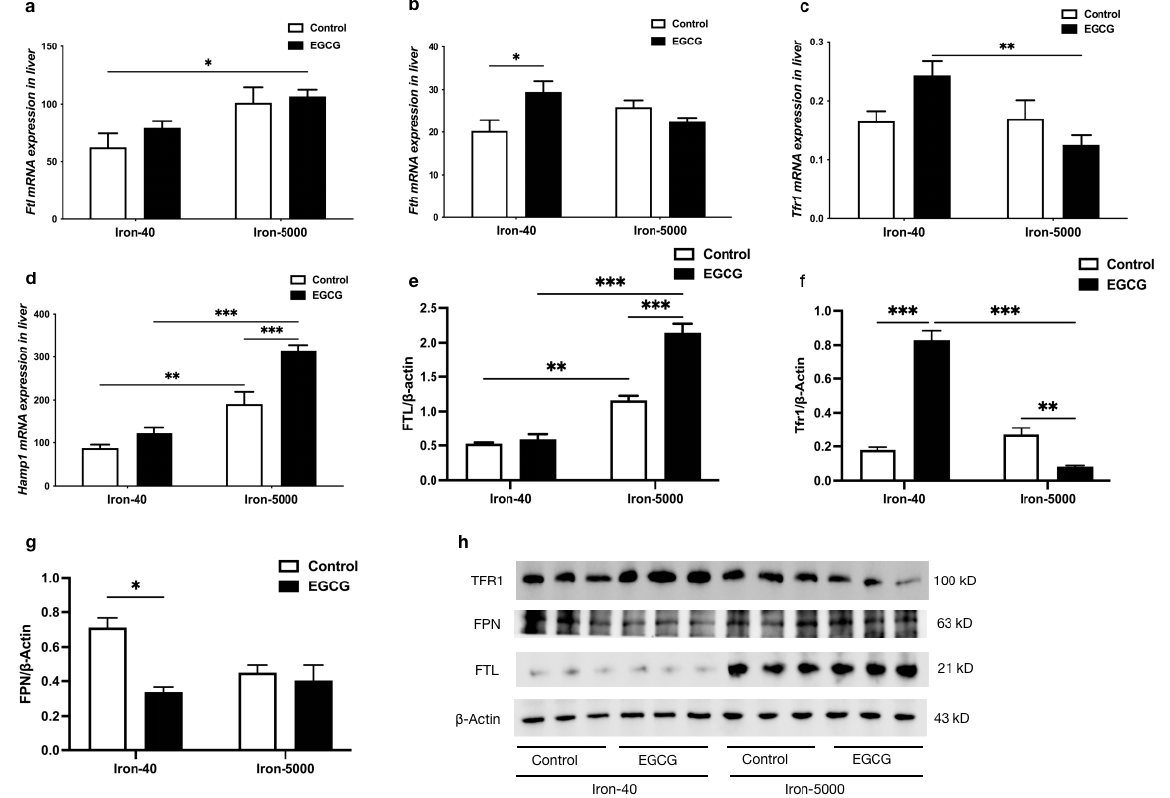
Figure 7. EGCG modulates iron metabolism factors to maintain iron homeostasis in mice. ( a – d ) Ftl , Fth , Tfr1 , and Hamp1 mRNA expression were tested by qPCR ( n = 10). ( e – g ) Quantification of FTH/L, TFR1, and FPN in the liver of each group of mice ( n = 3). ( h ) Western blot for FTH/L, TFR1, and FPN in the liver of each group of mice ( n = 3). The results of the two-way ANOVA are denoted by p -values, p < 0.05 (*), p < 0.01 (**), p < 0.001(***).